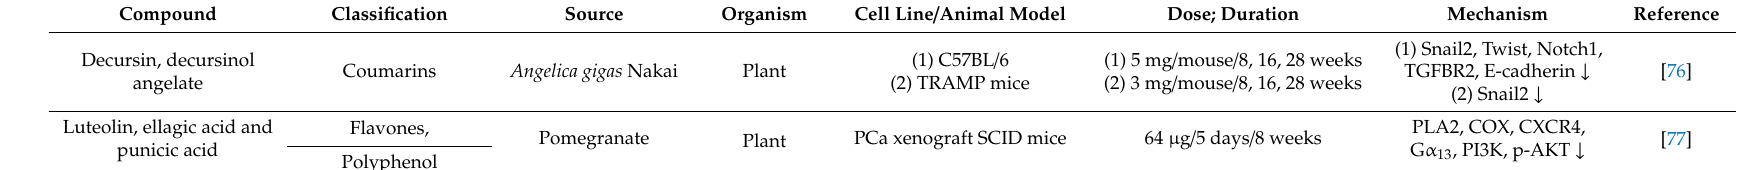
Table 6. Anti-metastasis inducing dietary compounds.